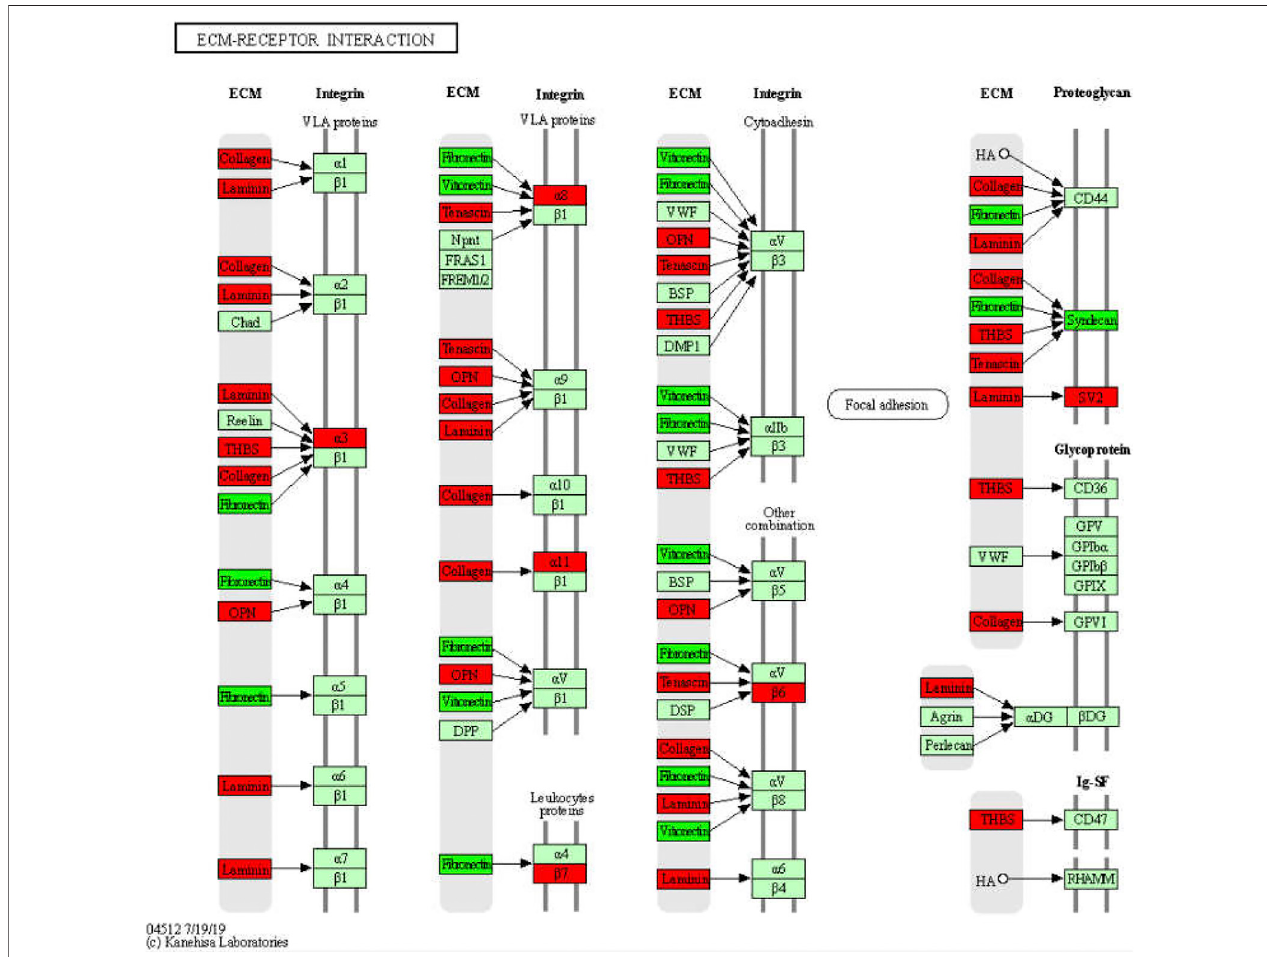
FIGURE 10 | Signi fi cantly enriched KEGG pathways in ECM-receptors